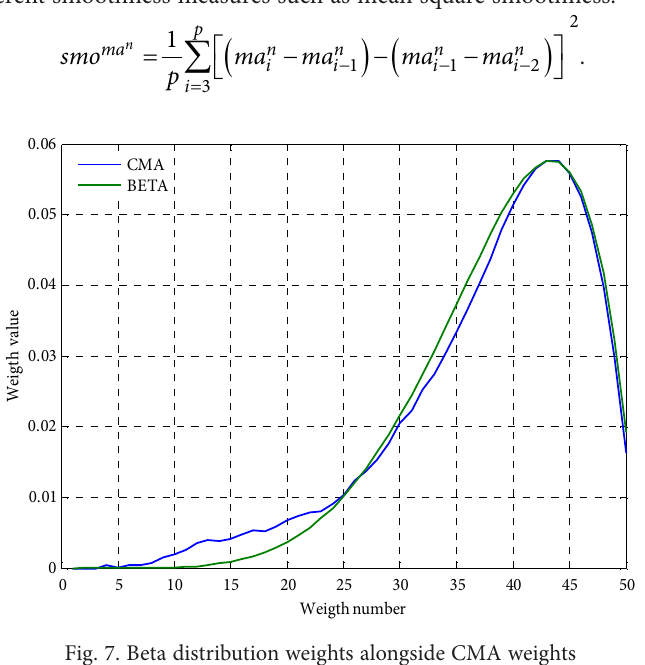
Fig. 7. Beta distribution weights alongside CMA weights